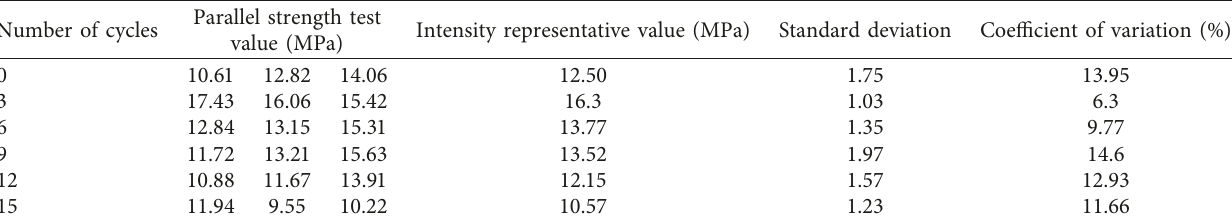
Table 3: Uniaxial compression experimental results of semirigid base material under the temperature range of 20 ° C ∼ 60 ° C. Number of cycles